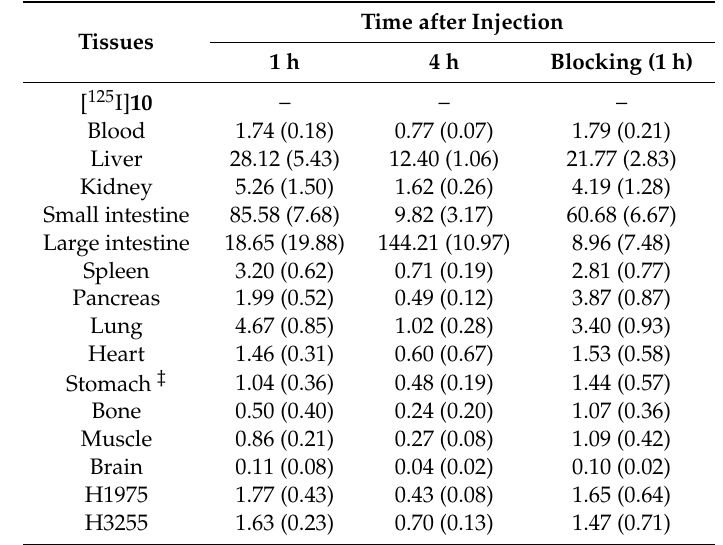
Table 4. Biodistribution of [ 125 I] 10 at 1 and 4 h after i.v. injection in tumor-bearing